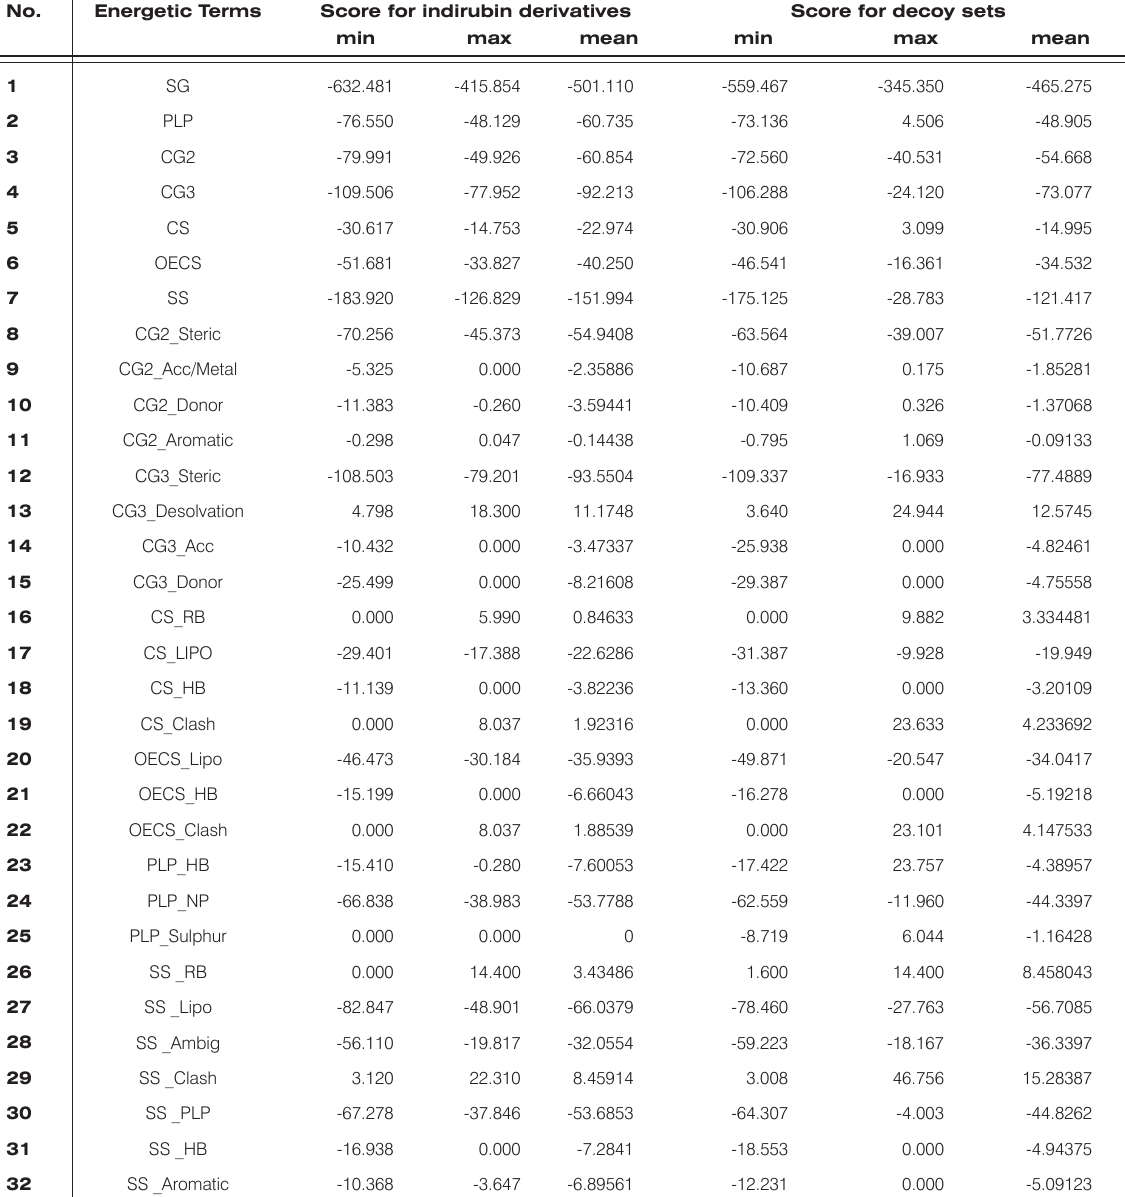
Table 2. The minimum, maximum and mean scores for indirubin derivatives and